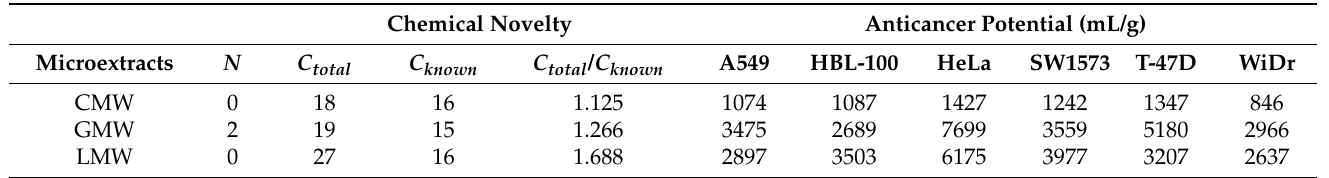
Figure 6. Anticancer potential of MW microextracts from Hypericum species. Table 3. Anticancer potential for the most bioactive MW Hypericum extracts.